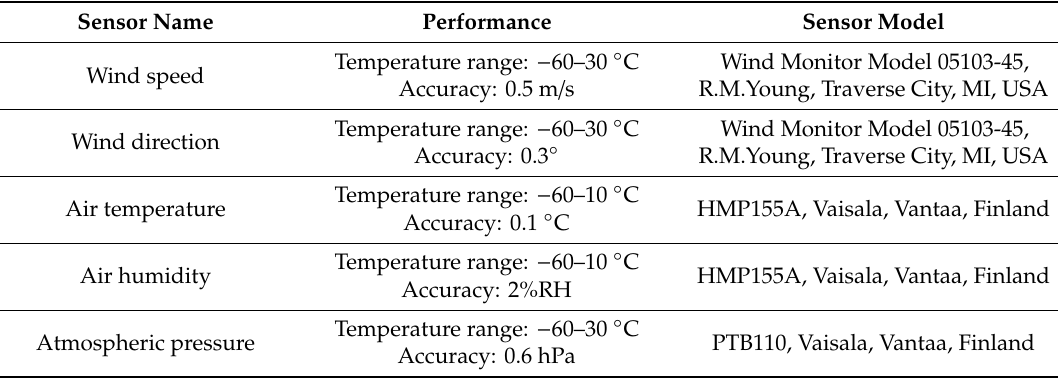
Table 1. Sensor information of the manned weather